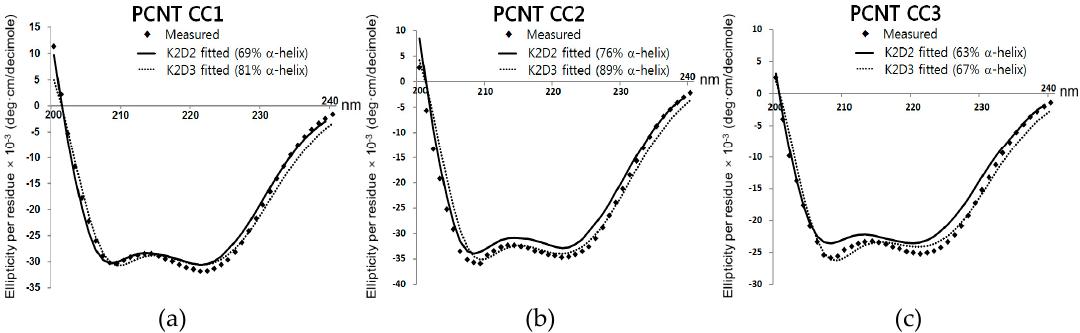
Figure 3. Circular dichroism studies for the estimation of secondary structure elements in PCNT ( a ) CC1, ( b ) CC2, and ( c ) CC3. ( a ) CC1, ( b ) CC2, and ( c )